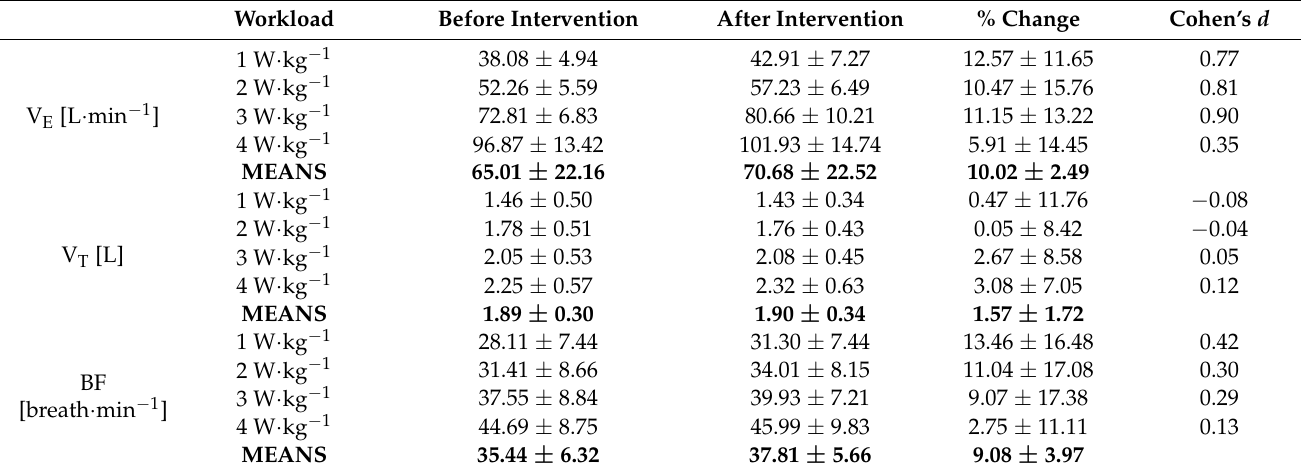
Table 1. Ventilation parameters before and after intervention in experimental group ( n =